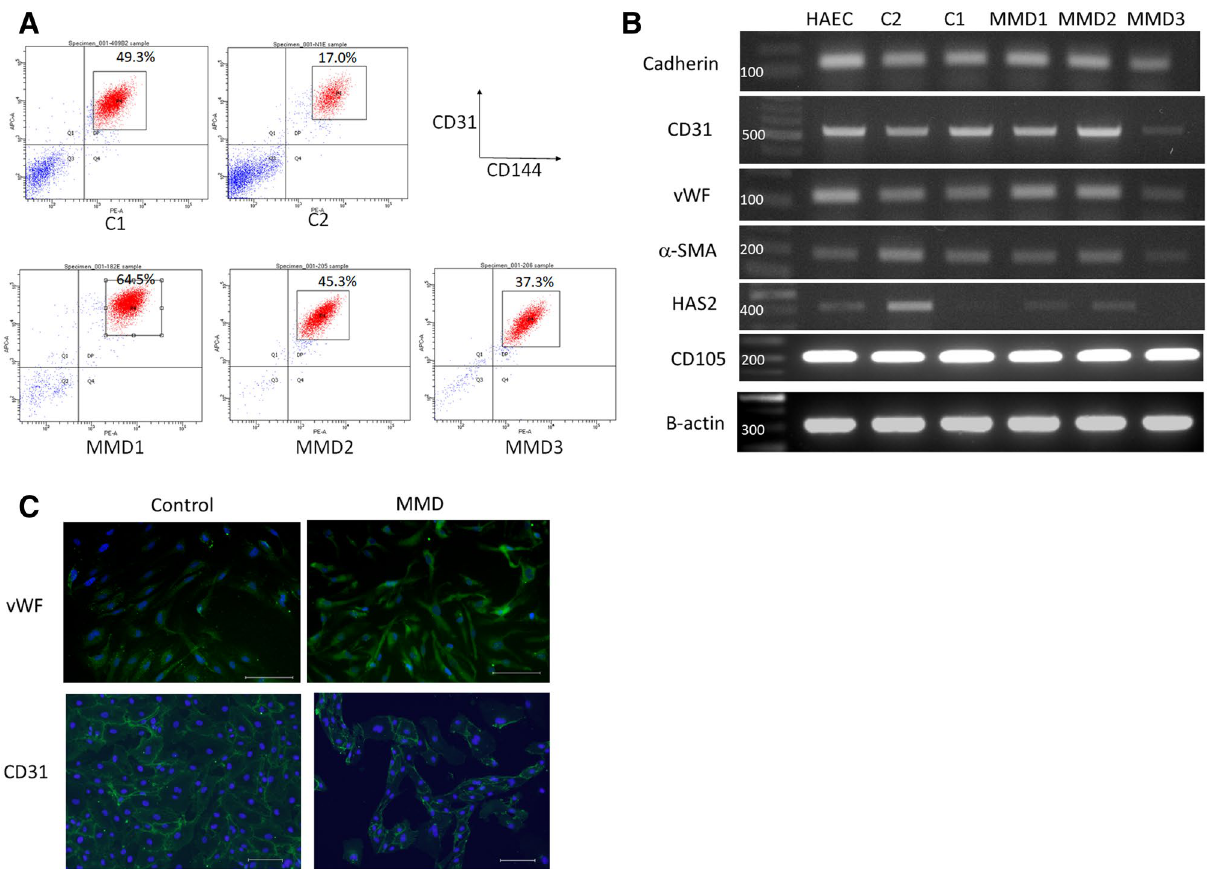
Figure 3. Endothelial differentiation of iPSCs derived from MMD and control. ( A ) FACS analysis of CD144 and CD31 in each differentiated iPSC sample. ( B ) RT-PCR results of endothelial-differentiated iPSCs (iPSECs). All purified cells had the endothelial cell markers, VE-cadherin, vWF, CD31 and CD105, and the smooth muscle cell marker, α-SMA. HAS2 was also expressed all iPSECs except for MMD3. HAEC, human aortic endothelial cell. The original full-length gels were provided as supplementary figures (Figure S3). ( C ) Representative photographs of immunofluorescence for vWF and CD31. Scale bar: 100